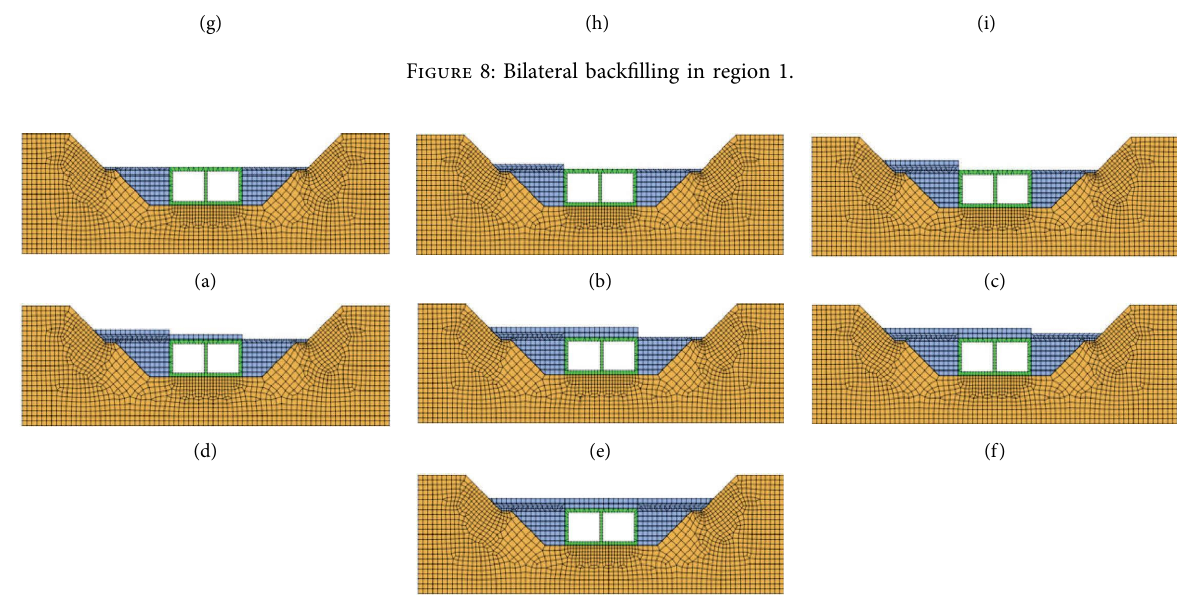
Figure 9: Backflling from left-to-right: Case I.